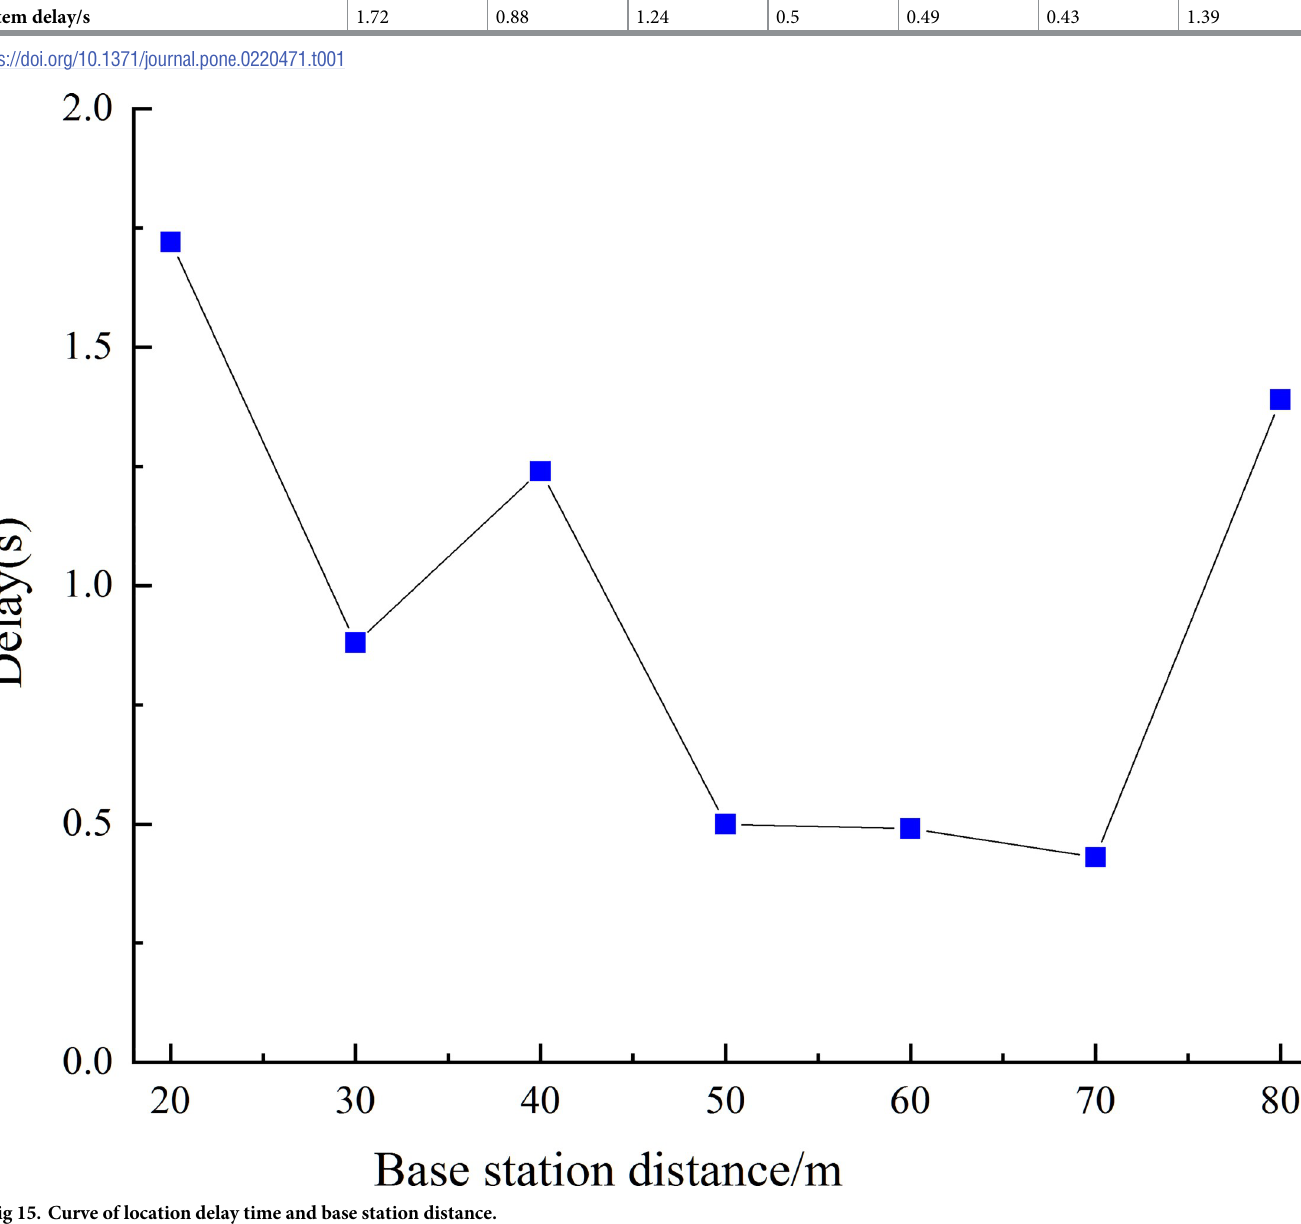
Fig 15. Curve of location delay time and base station distance.